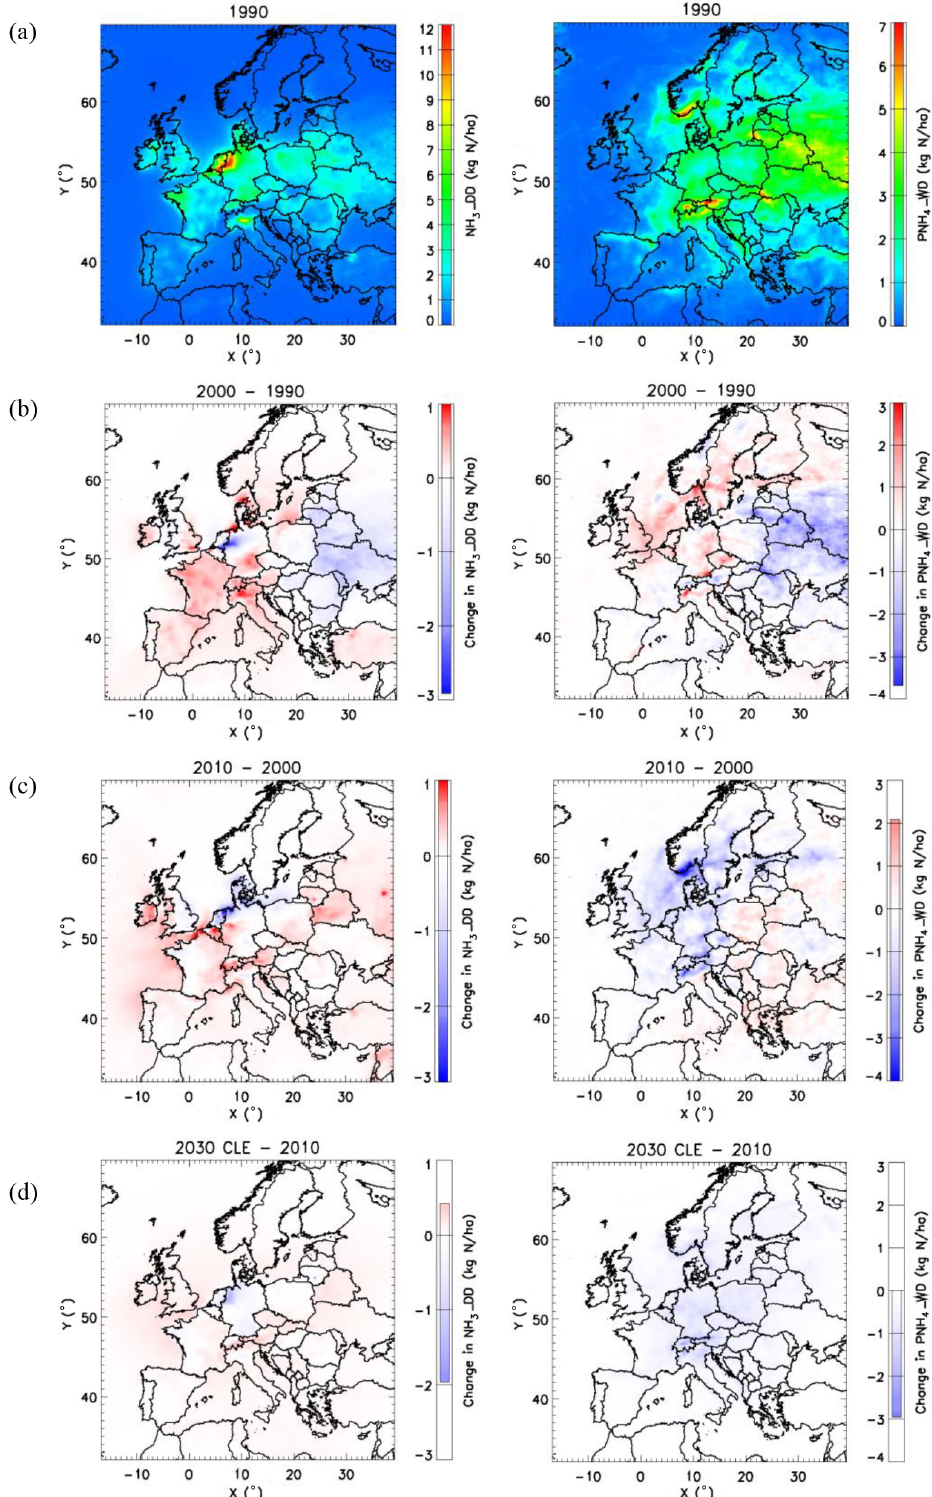
Figure 4. Dry deposition of ammonia (left panels) and wet deposition of ammonium (right panels): (a) accumulated deposition (kgNha − 1 ) in 1990; changes (kgNha − 1 ) between (b) 1990 and 2000, (c) 2000 and 2010, and (d) 2010 and